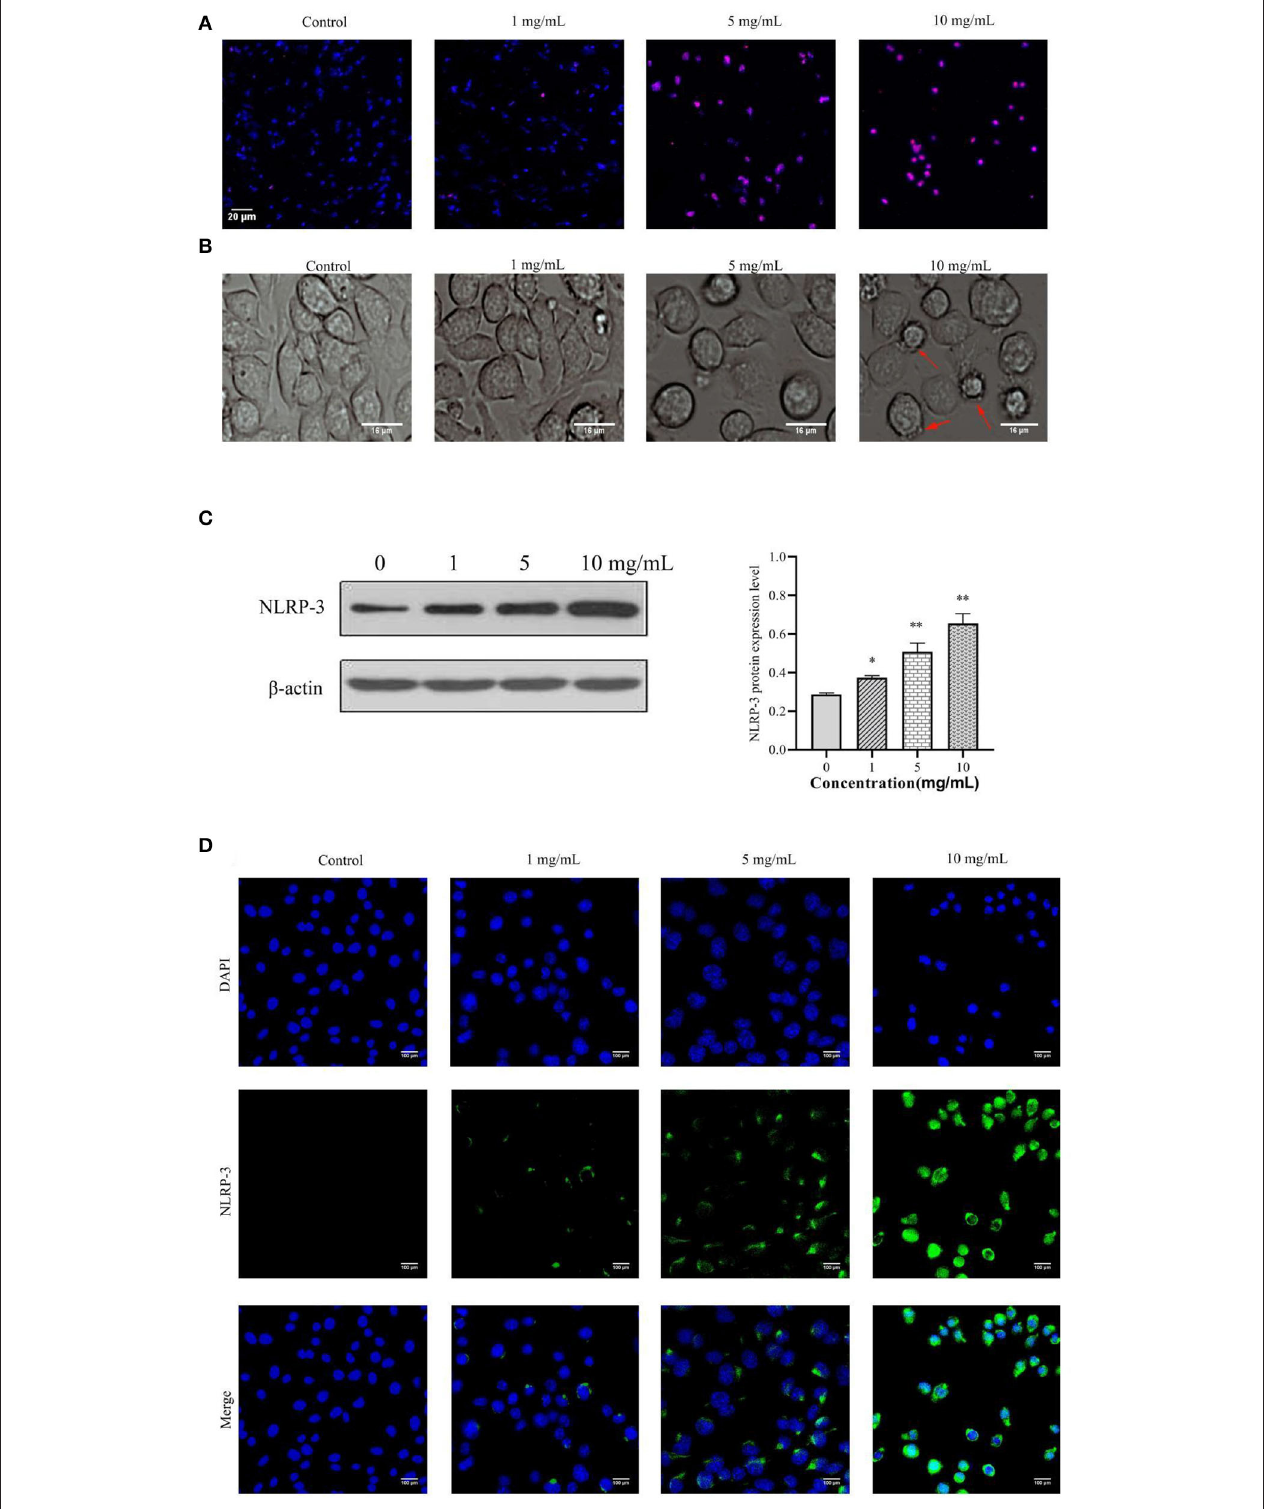
FIGURE 3 | 11S glycinin induced DNA damage and increased the NLRP-3 expression in IPEC-J2 cells. IPEC-J2 cells were treated with different concentration of 11S glycinin (0, 1, 5, or 10 mg · ml − 1 ) for 24h, respectively. (A) TUNEL shown the DNA damage of IPEC-J2 cells. (B) The morphology of IPEC-J2 cells after 11S glycinin treatment. (C) Western blotting presented the protein expression level of NLRP-3 in IPEC-J2 cells. (D) Immunofluorescence imaging of the NLRP-3 antibody in IPEC-J2 cells. Data are shown as mean ± SD. * P < 0.05, ** P < 0.01, compared with the control